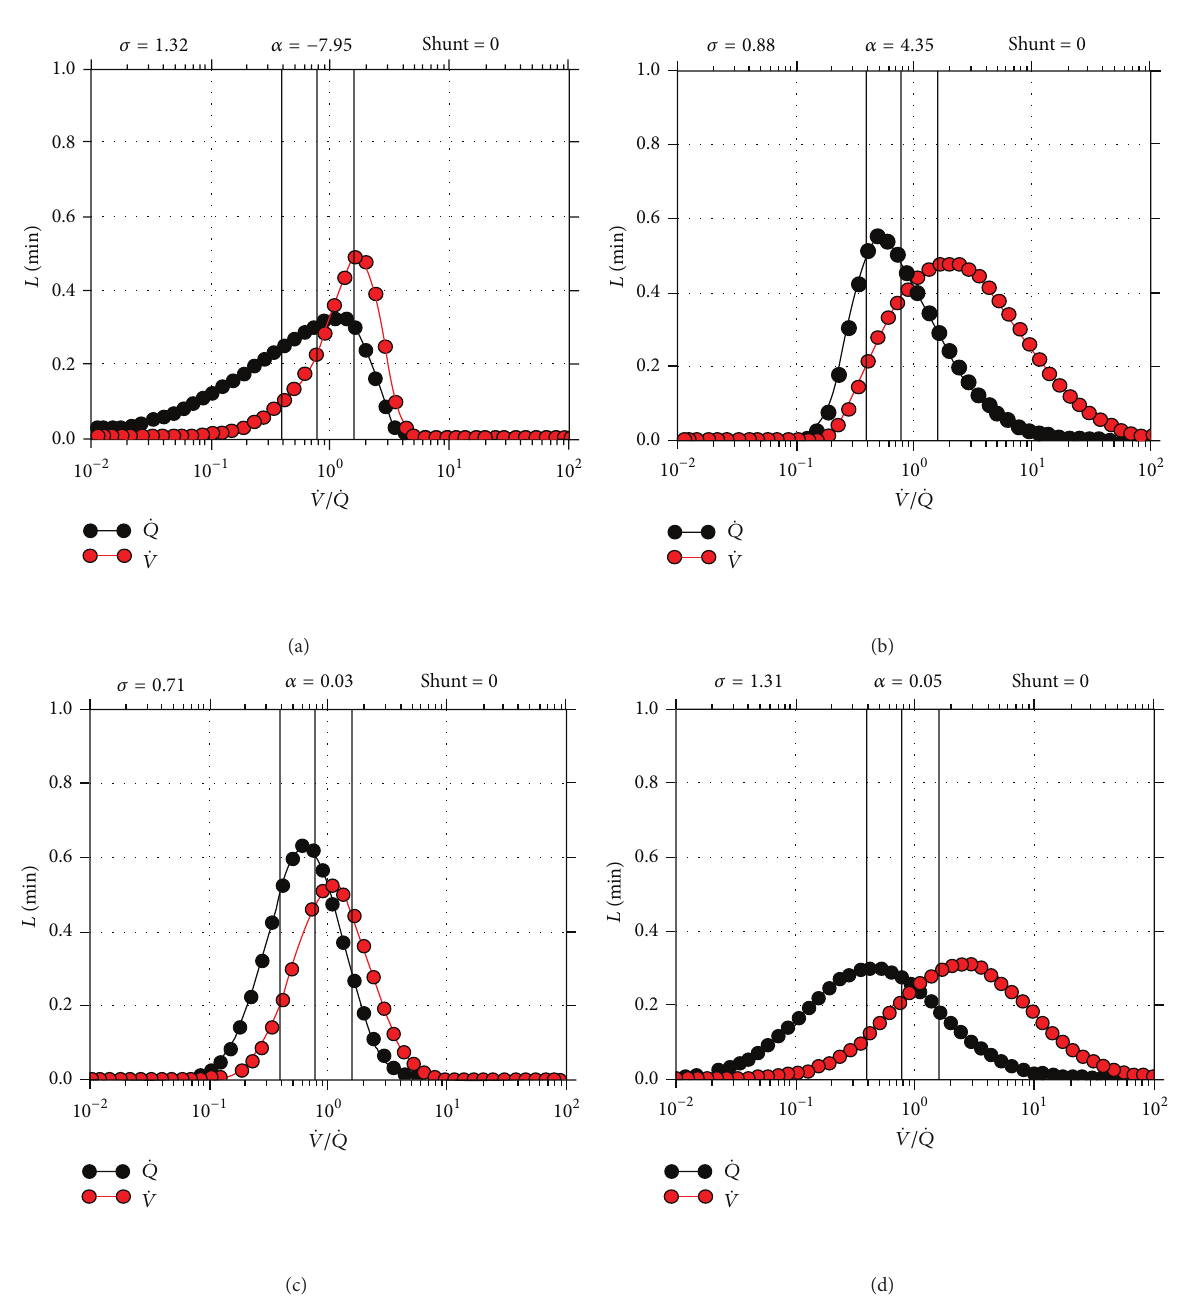
Figure 2: Representative pulmonary gas exchange abnormalities (GEA) patterns in patients with typical RTT and MeCP2 gene mutation: (a) “low pattern” abnormality; (b) “high pattern” abnormality; (c) “simple 𝑉/𝑄 mismatch”; and (d) “mixed pattern” abnormality. Ventilation- perfusion ( 𝑉/𝑄 ) inequalities (i.e., GEA) were detectable in 80.7% of the whole RTT population, whereas only 19.3% of the patients showed a normal gas exchange. A “low” pattern (i.e., 34.8 of all GEA types in RTT) indicates the presence of perfusion in poorly ventilated pulmonary areas; a “high” pattern (i.e., 39.8% of all GEA types) points out the existence of high ventilation in poorly perfused pulmonary areas; a mixed pattern (i.e, 19.6% of all GEA types) is a combination of the former two patterns, while a “simple mismatch” (i.e., 5.9% of GEA types) is a 𝑉/𝑄 uncoupling, showing a modest fraction of low 𝑉/𝑄 ratios (1 to 0.1) and a modest fraction of high 𝑉/𝑄 ratios (1 to